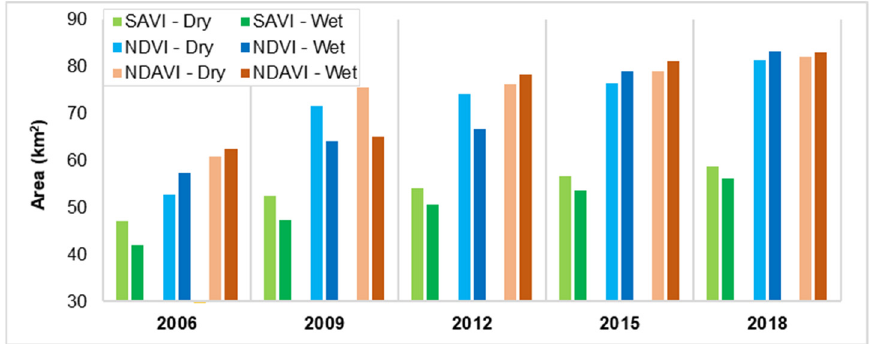
Figure 4. NDVI, SAVI, and NDAVI areas in Lake Titicaca for dry and wet periods.